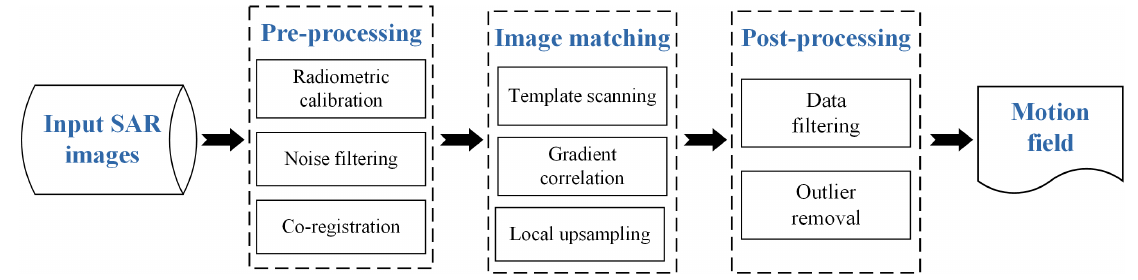
Figure 1. Workflow of glacier surface motion estimation using SAR intensity images.